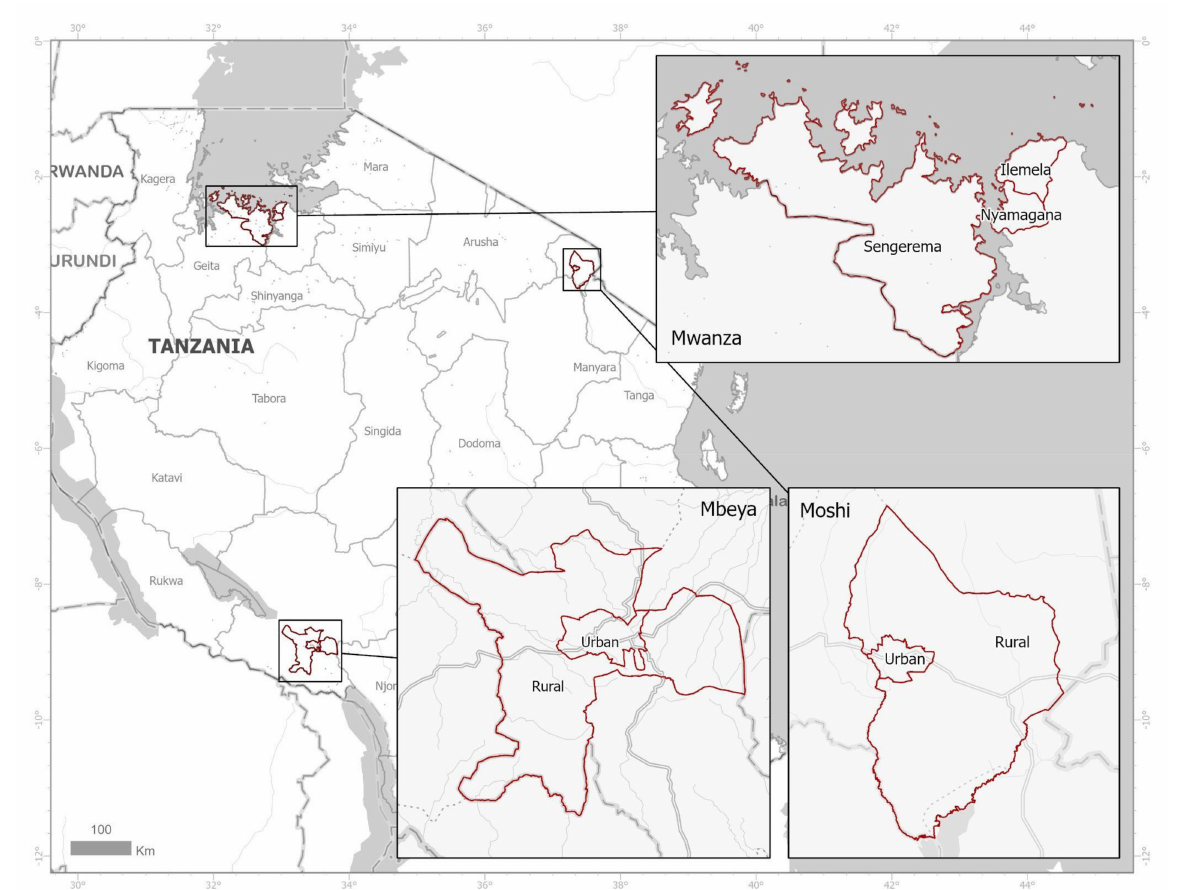
Figure 1. Location of our three study areas within